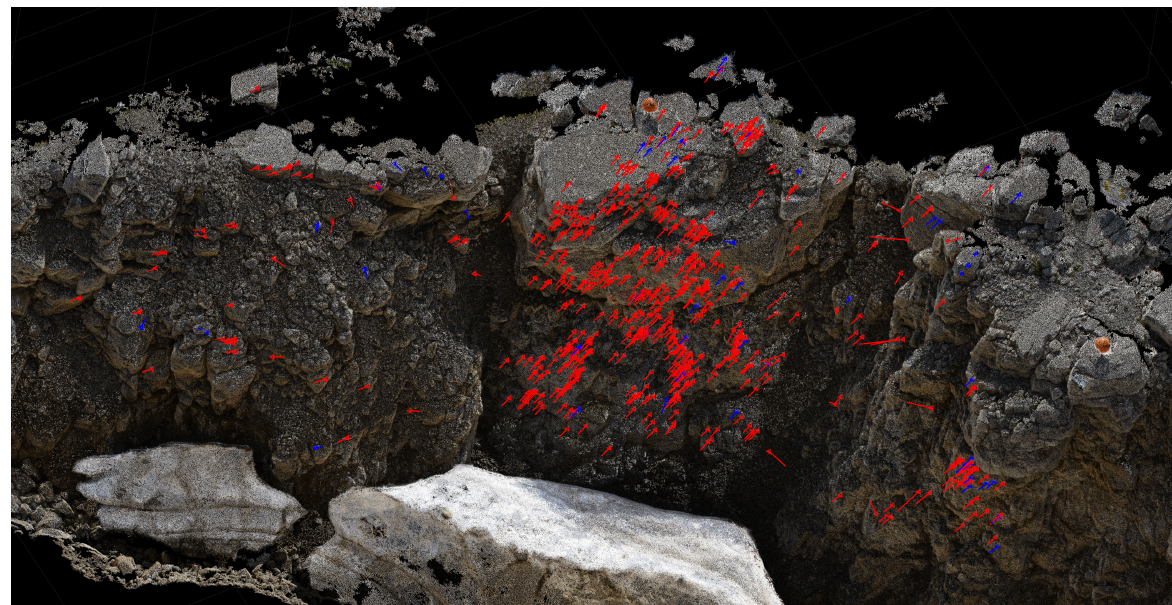
Figure 5. Estimated motion vectors between the epochs 2018 and 2021. Red arrows belong to significant and blue arrows to non significant vectors. The point cloud of 2021 calculated using Pix4D is also shown for illustration. The length of the vectors is scaled by a factor of 3.